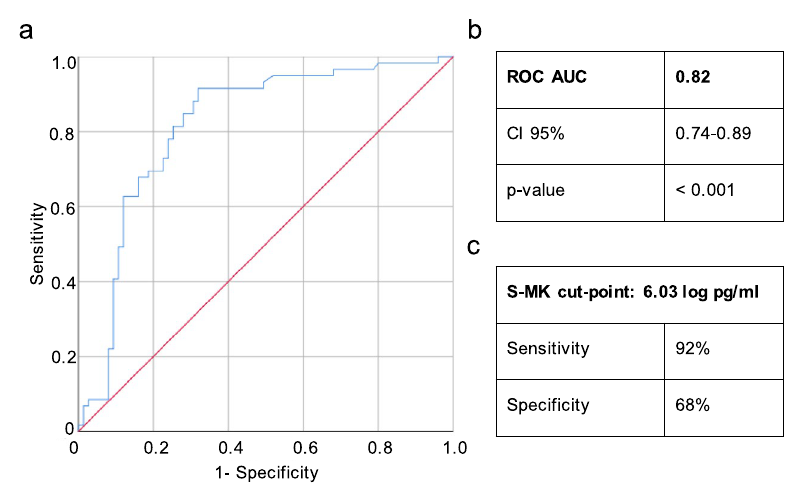
Figure 4. High diagnostic power of S-MK concentration to discriminate NSCLC from healthy controls. Abbreviations: S-MK serum-midkine, NSCLC non-small lung cancer, pg picogram, ml milliliter, CI confidence interval. ( a ) The blue solid line represents an estimated ROC curve for distinguishing NSCLC patients from healthy individuals based on the S-MK concentration. Sensitivity (true positive rate) is plotted versus 1-specificity (false positive rate) for all possible values of S-MK concentration. The red line reflects the ROC curve for random guessing. ( b ), ( c ) The calculation is based on the retrospective analysis of 59 NSCLC patients and 73 healthy control individuals. AUC = 0.82 (CI 95% 0.741–0.892; p <